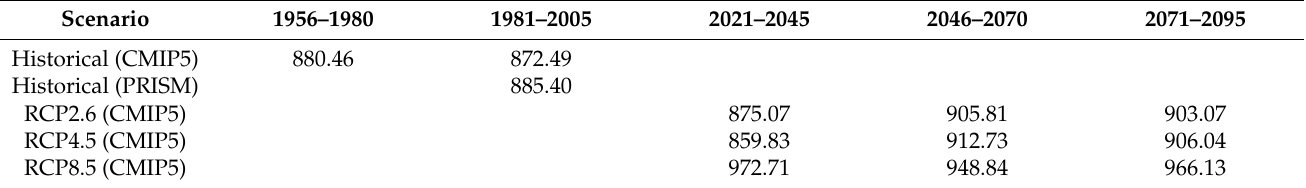
Table 4. Average annual precipitation by climate scenario